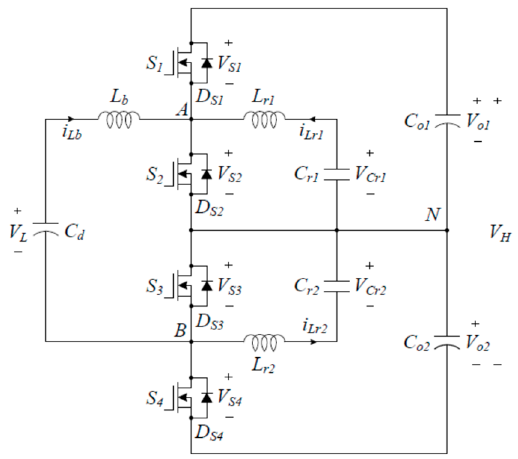
Figure 2. Circuit diagram of the proposed converter.